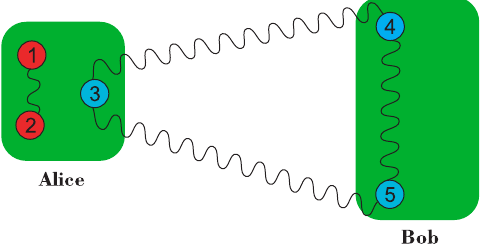
Figure 6. An EPR state can be teleported by using a GHZ state as the quantum channel. In this case, a measurement in the GHZ basis is also necessary.